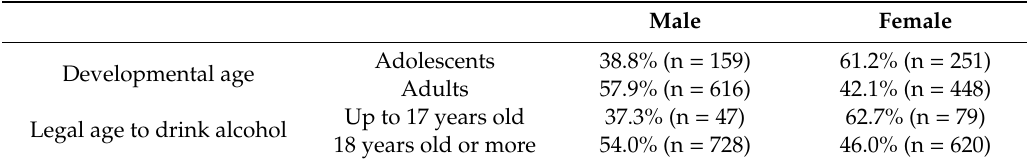
Table 1. Proportion and number of males and females in each group of